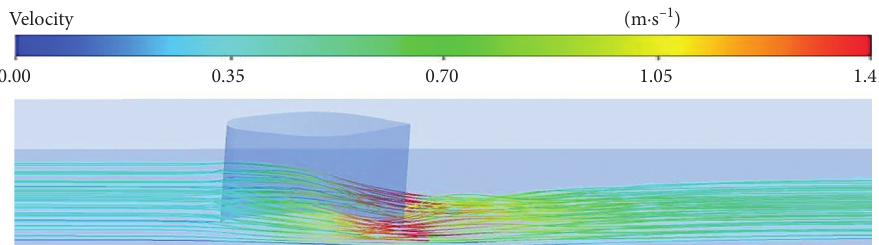
Figure 10: The streamline distribution in the portable pillar-shaped